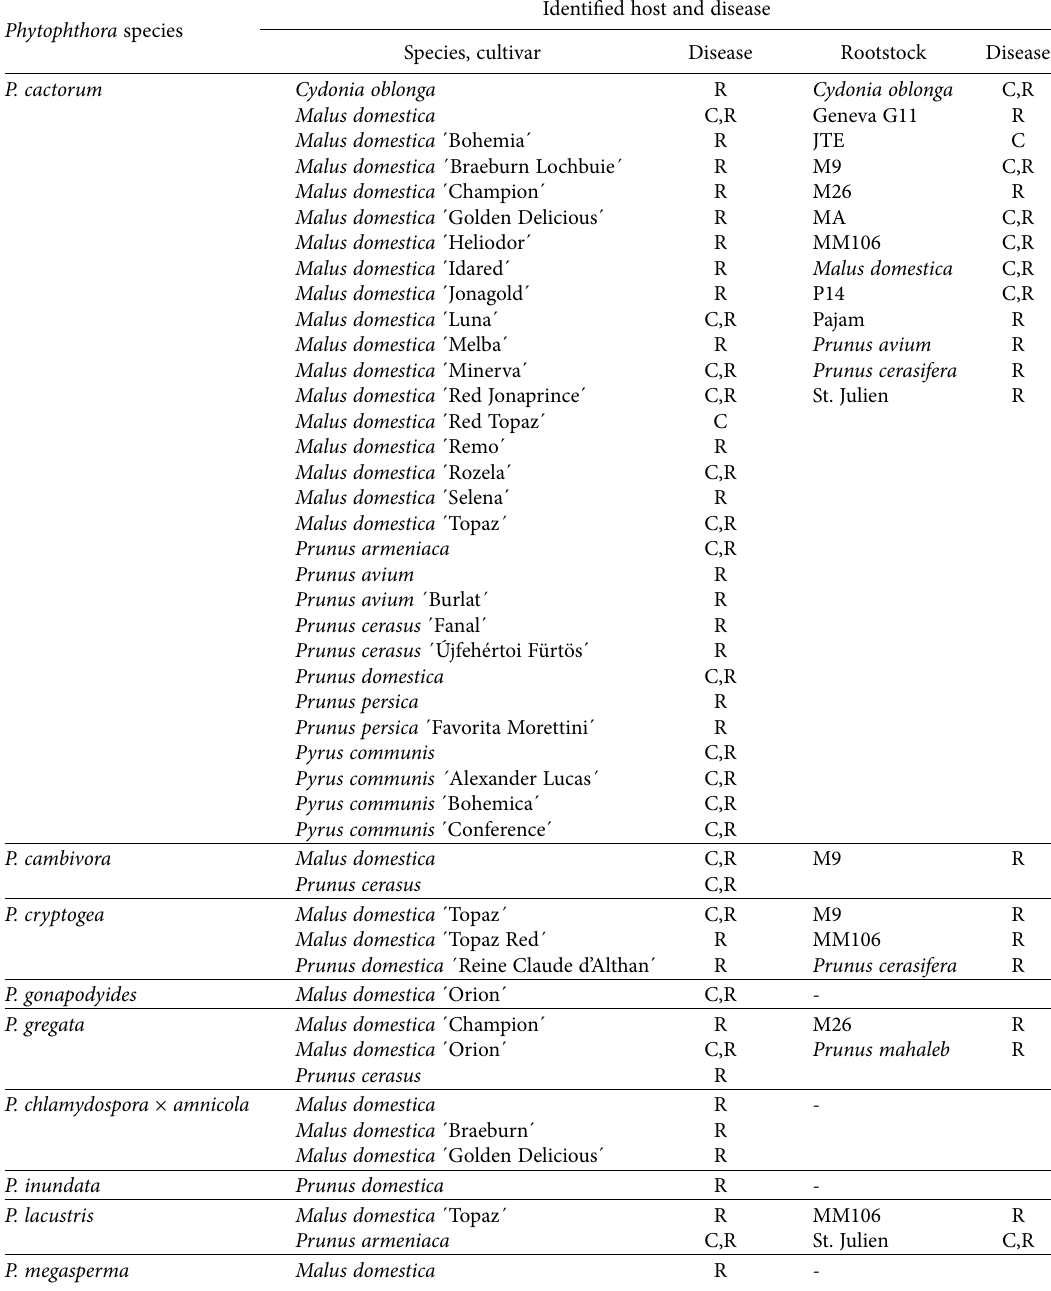
Table 1. Overview of Phytophthora spp. isolated from fruit trees (host species, cultivars and rootstocks) and diseases they caused (C: collar rot, R: root rot) in the Czech